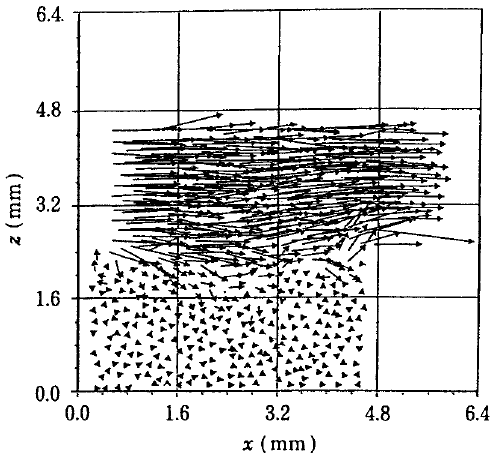
Fig. 10 . Particle velocity vector diagrams ( σ zz = 990Pa, Y = 2.3 〜 2.5mm, t = 0.032s)